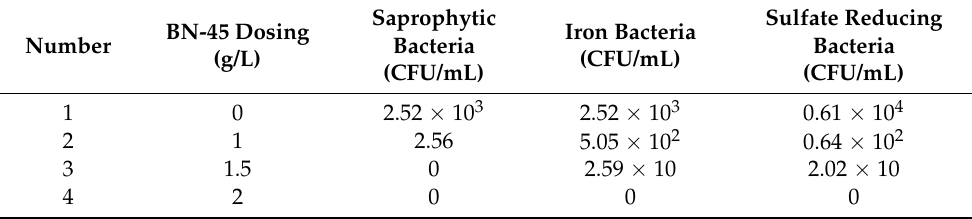
Table 6. Bactericidal properties in different doses of water-based annular air protection solution.